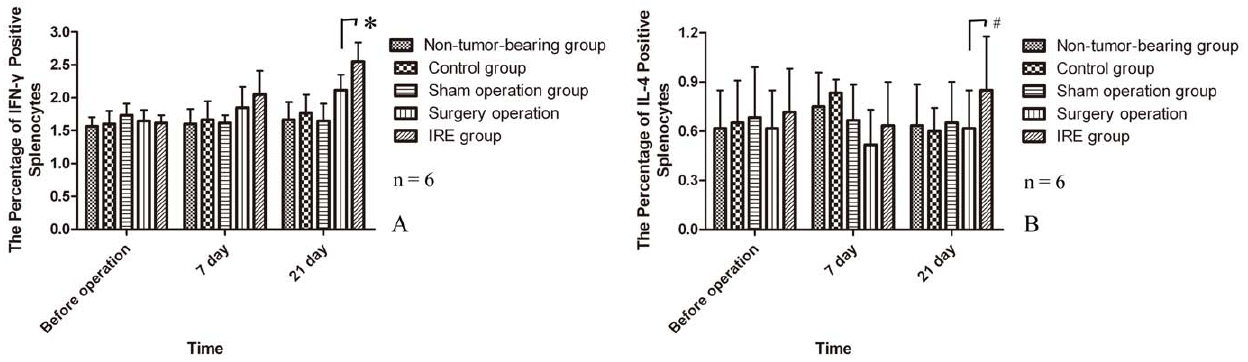
Figure 5. Changes in the serum sIL-2R (A) and IL-10 (B) levels of peripheral blood. *p , 0.05; # p . 0.05.